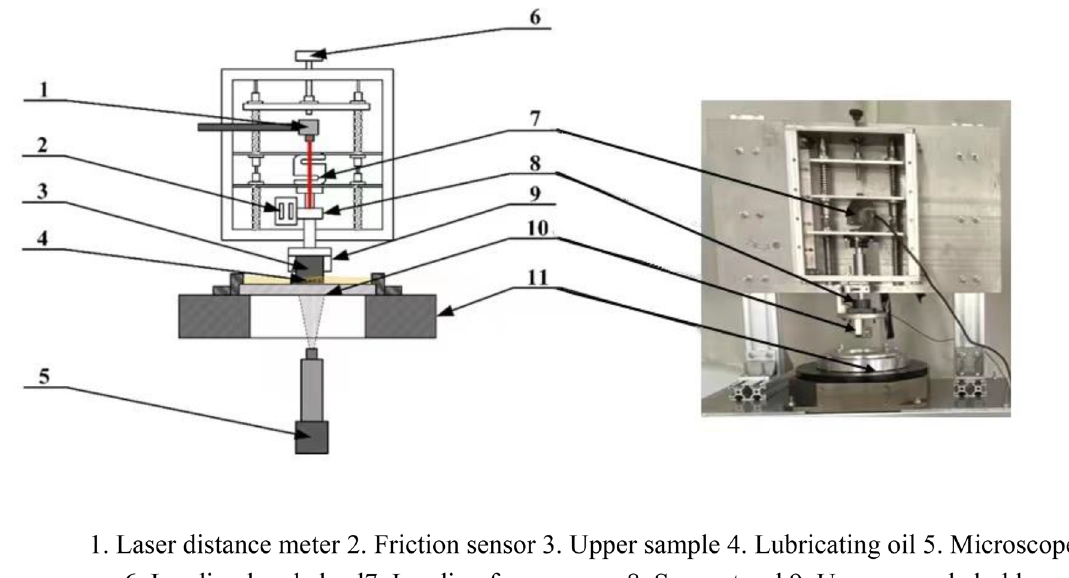
Figure 2. Sample and fixture assembly